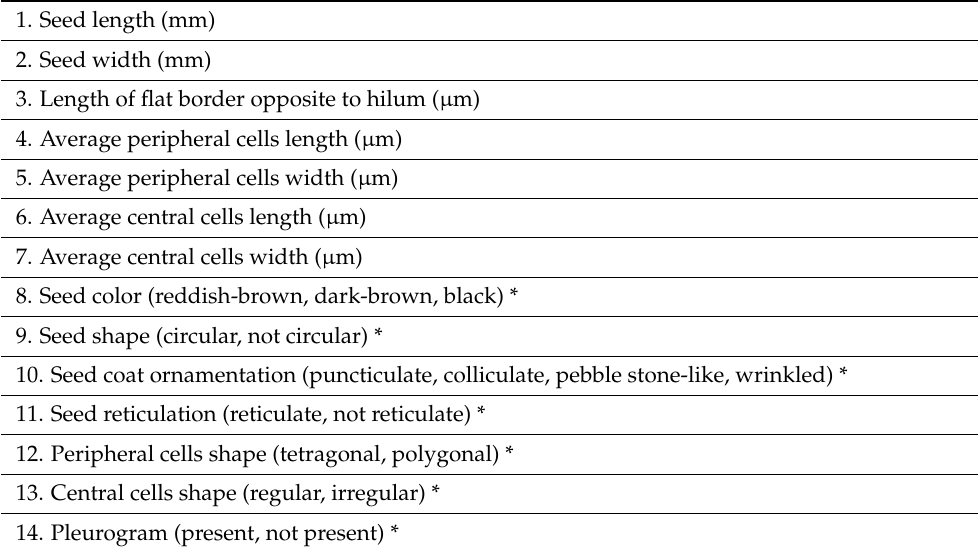
Figure 1. Map of the countries referring to the studied samples. Abbreviations: Ar = Argentina, Au = Australia, B = Bosnia and Herzegovina, Be = Belgium, C = Congo Democratic Republic, E = Equador, In = India, M = Mozambique, P = Pakistan, R = Romania, S = Serbia, Sar = Saudi Arabia, Sp = Spain, SAf = Republic of South Africa, Tu = Turkey, USA = United States of America. Table 1. List of the Amaranthus taxa studied (alphabetical order). Native distribution areas from Table 2. Characters measured for the morphometric analysis. The characters labelled with an asterisk [41] and, concerning A. blitum , from [3]. S: South; W: West; N: North: E: East; C: Central. (*) are qualitative, and the others are quantitative (see Table